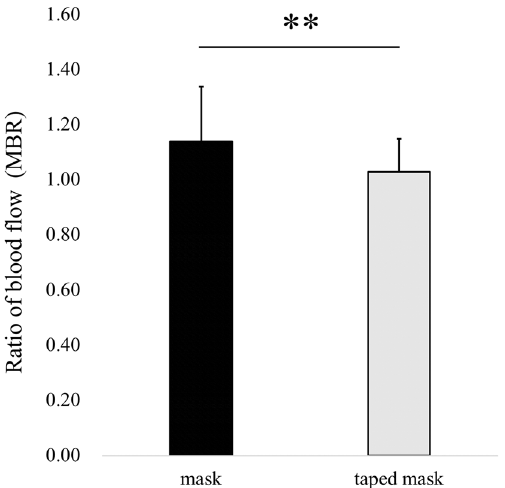
Figure 4. Comparison of the bulbar conjunctival blood flow rates between the no mask and mask or taped mask groups. The asterisks indicate significant differences during these conditions (** P < 0.01, paired t-test). MBR, mean blur rate.